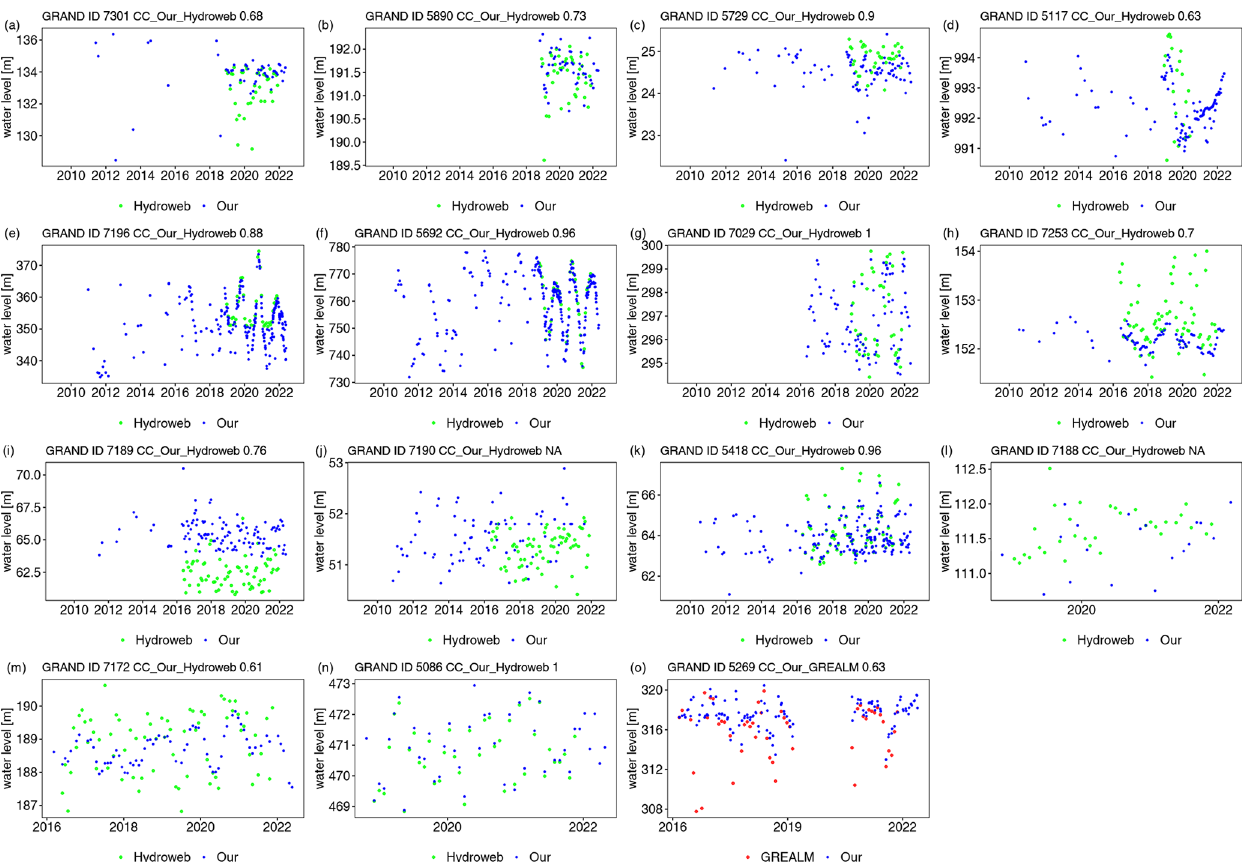
Figure C1. DAHITI is plotted in black, G-REALM in red, Hydroweb in green, our dataset in blue, and in situ records with a black line. RMSE values are given when in situ observations are available; otherwise, CC values are given at the top of each